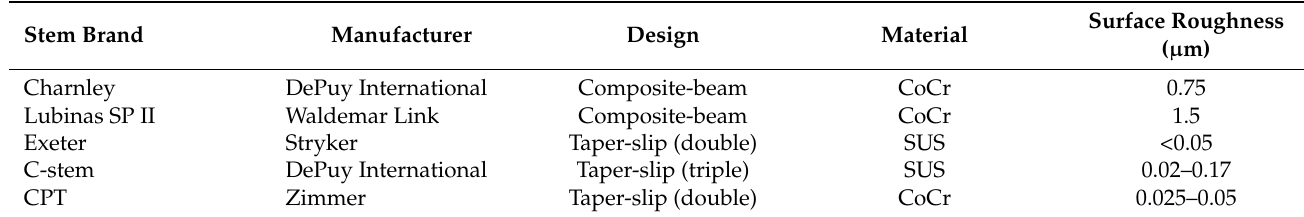
Table 6. List of the major available cemented